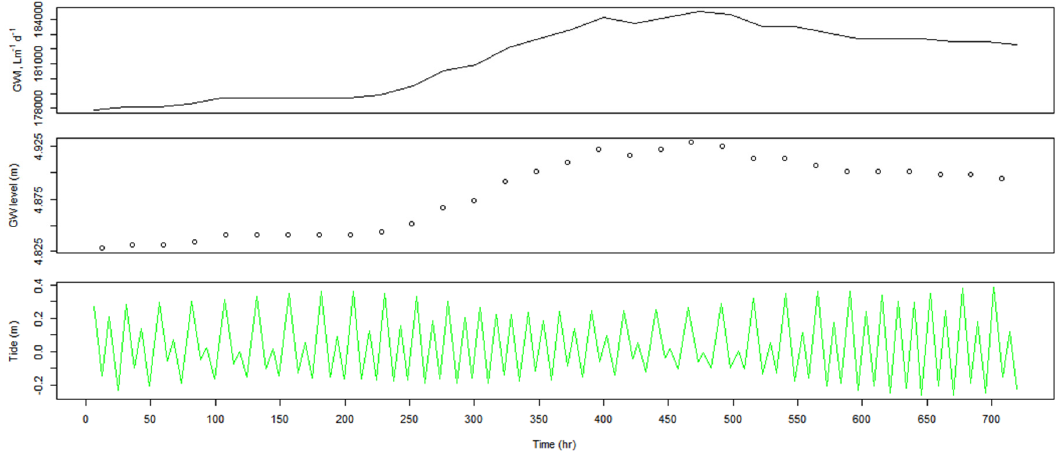
Figure 8. One month time period: tidal predictions (Ford Island Ferry station), observed groundwater levels (Aiea US Navy 187-B), and GWI rates for main with theoretical mild defect ( β = π /90, 1.3 cm arc).